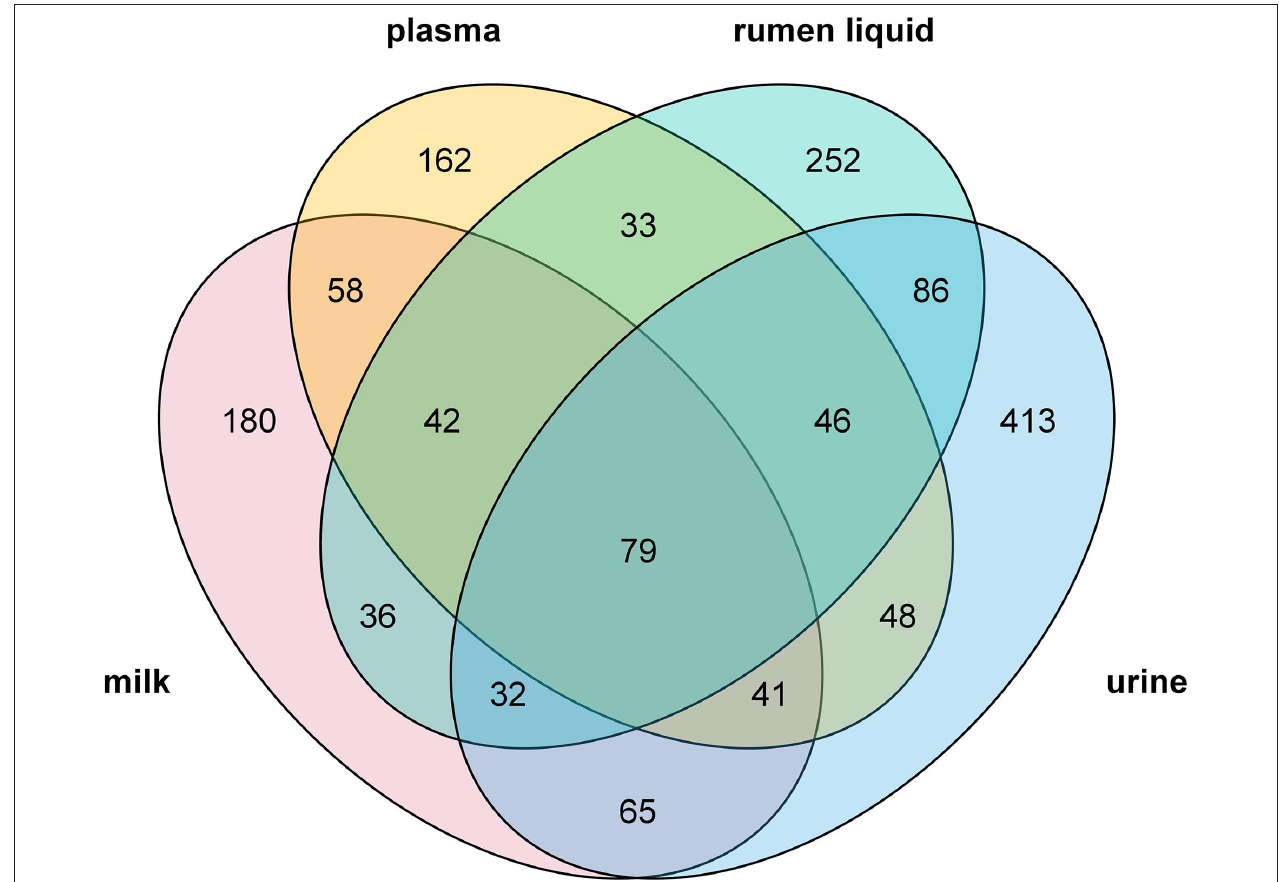
FIGURE 1 | Venn diagram illustrating the unique and common metabolites detected in the rumen liquid, plasma, milk, and urine.